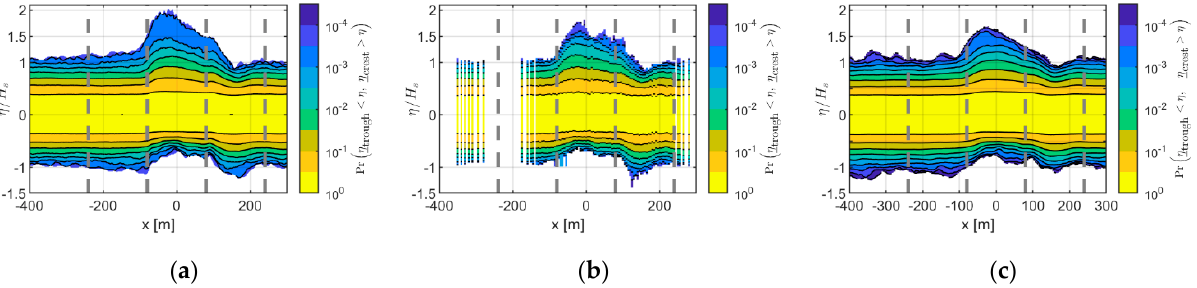
Figure 10. The crest and trough exceedance for H2.5T11 over the main interval for ( a ) simulation of 1D long-crested waves, ( b ) measurement, and ( c ) simulation of short-crested waves.